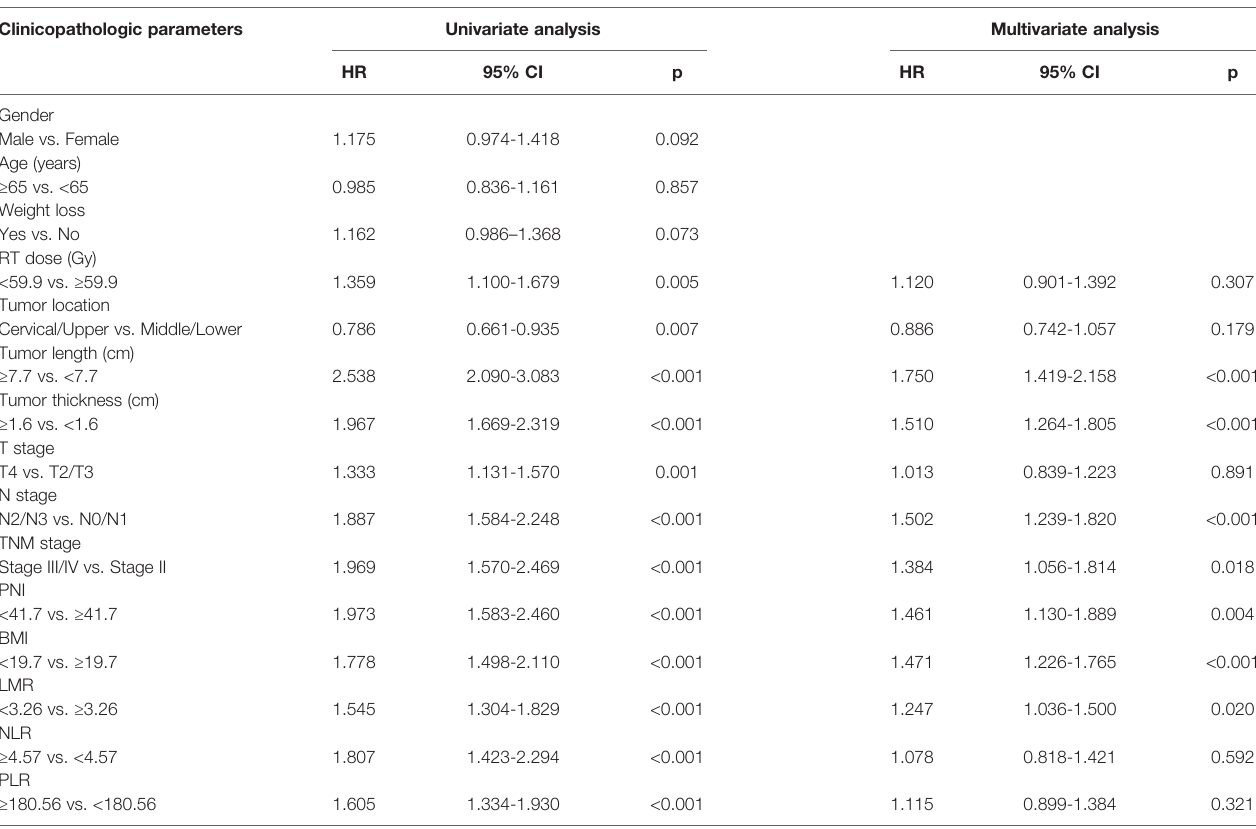
TABLE 3 | Univariate and multivariate analyses of prognostic factors for PFS in patients with ESCC.